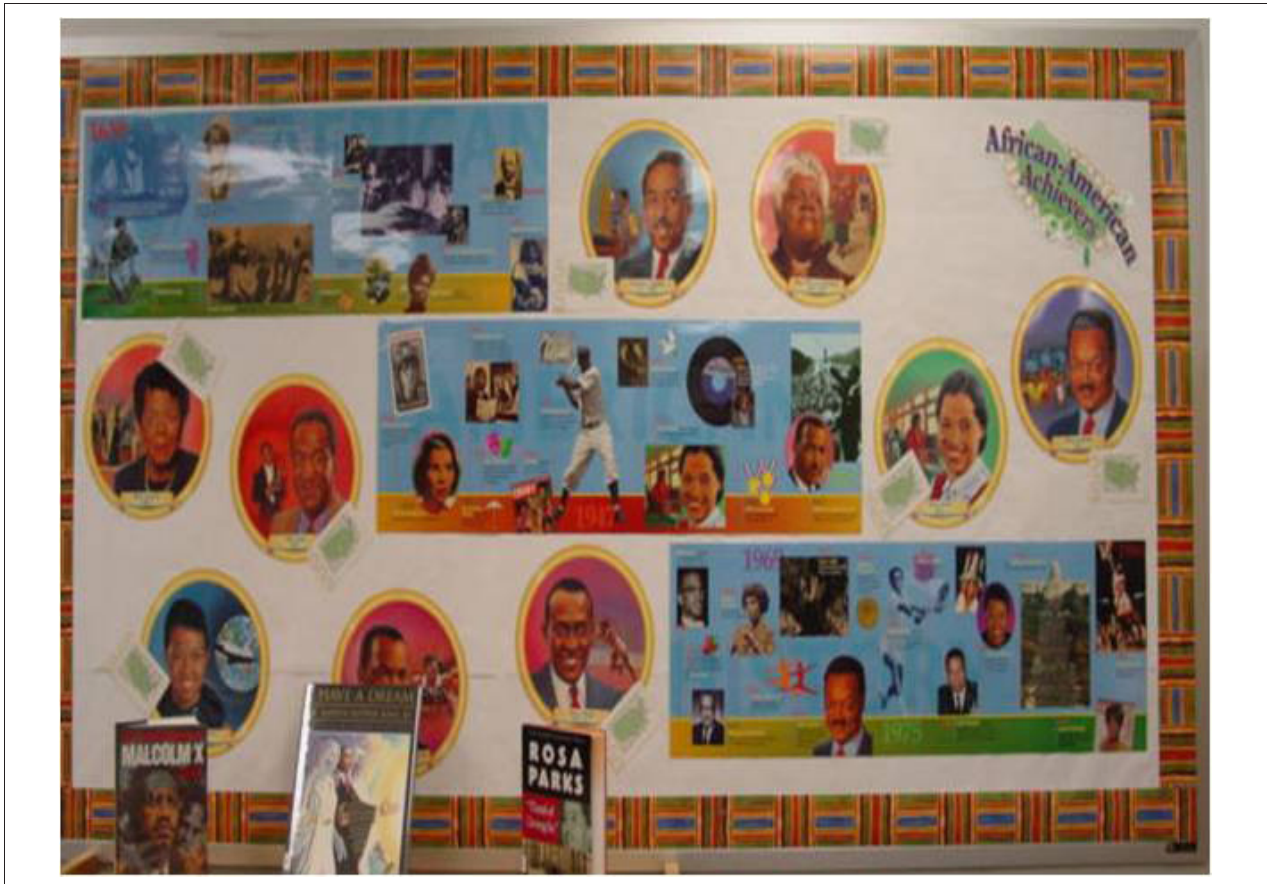
FIGURE 2 | Example of a commercially-produced centralized display for Black History Month from a White-Majority school, Study